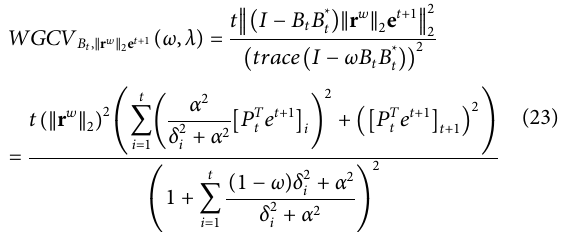
algorithm. Due to the comparison between the